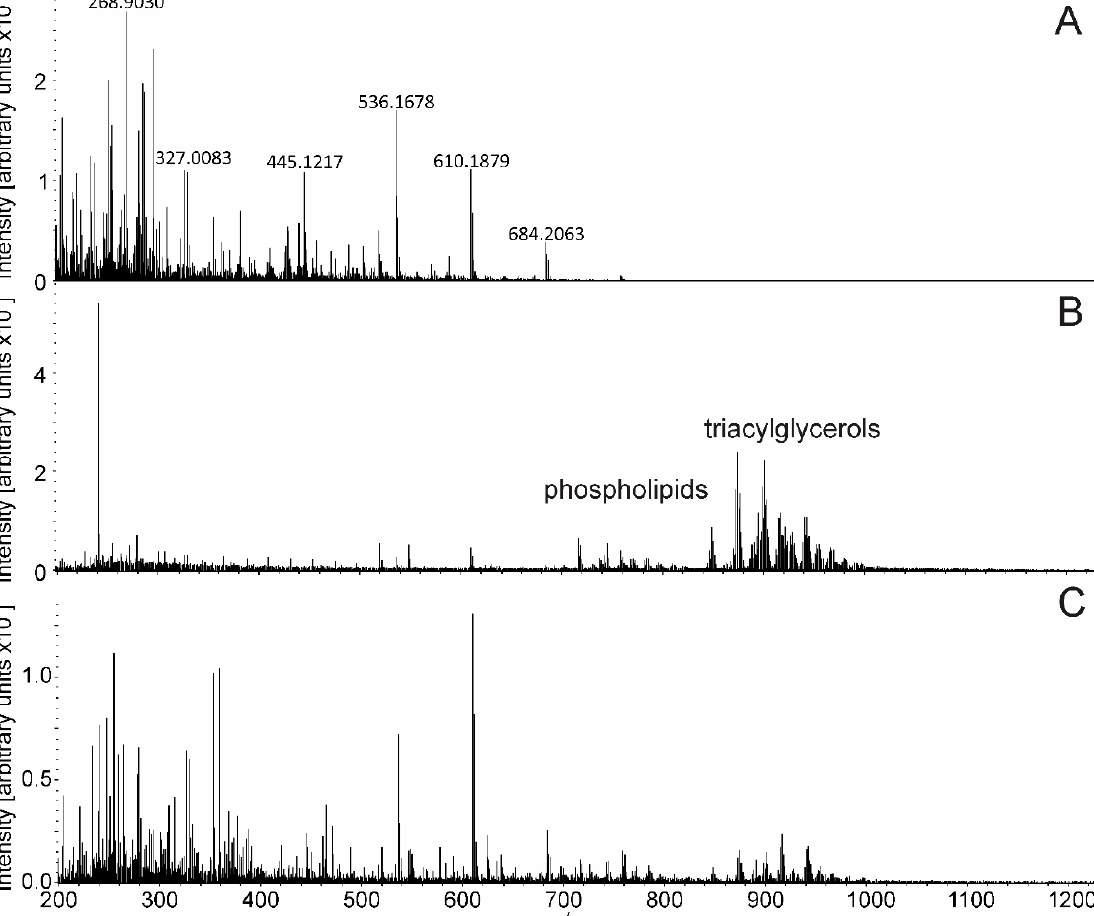
Figure 3. Low-temperature electrosurgery unit mass spectrometry (LTEU-MS) spectrum ( A ), LTEU- extractive electrospray ionization (EESI)-MS spectrum ( B ) and a mass spectrum obtained with high-temperature electrosurgery unit ( C ). Chicken skin was used as sample.